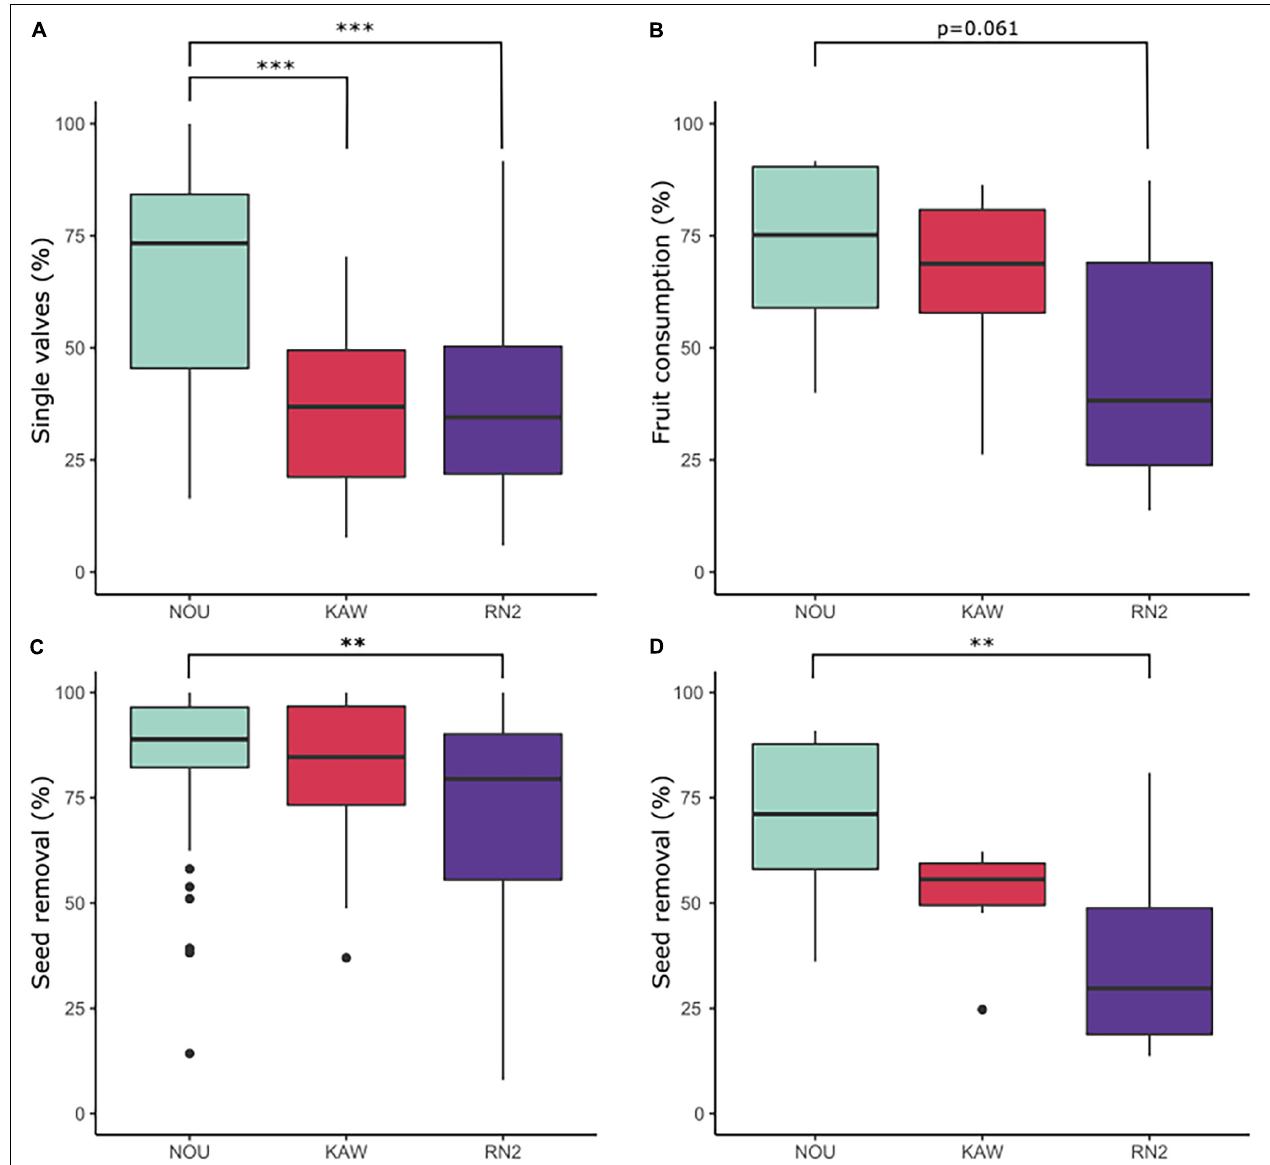
FIGURE 6 | Box-plots representing indices of fruit fate and seed removal at Nouragues field station (NOU), Montagne de Kaw (KAW) and along Road “Nationale 2” (RN2): (A) percentage of Virola spp. fruits found as single valves; (B) percentage of Manilkara spp. fruits consumed (fruit consumption rate); (C) percentage of seed removal of Virola spp. and (D) Manilkara spp. Percentages were compared with Kruskal-Wallis rank-sum tests and a Pairwise-Wilcoxon statistical tests. ∗∗∗ p < 0.001; ∗∗ p <